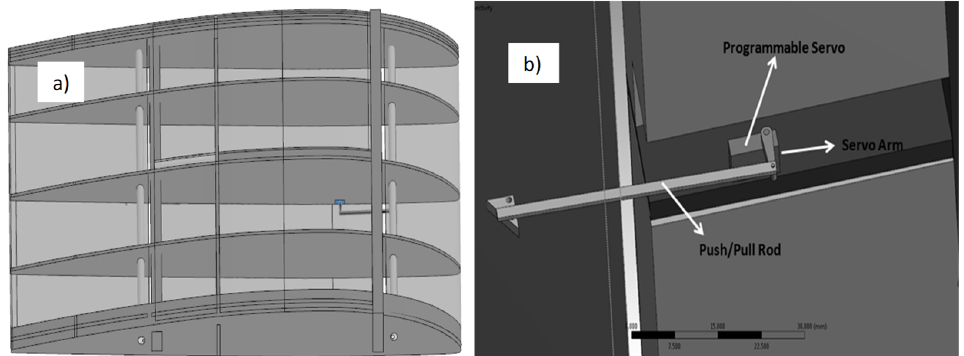
Figure 17. ( a ) Top view of the leading edge adaptive wing prototype; ( b ) actuator design is composed of a servo motor and a push/pull rod.